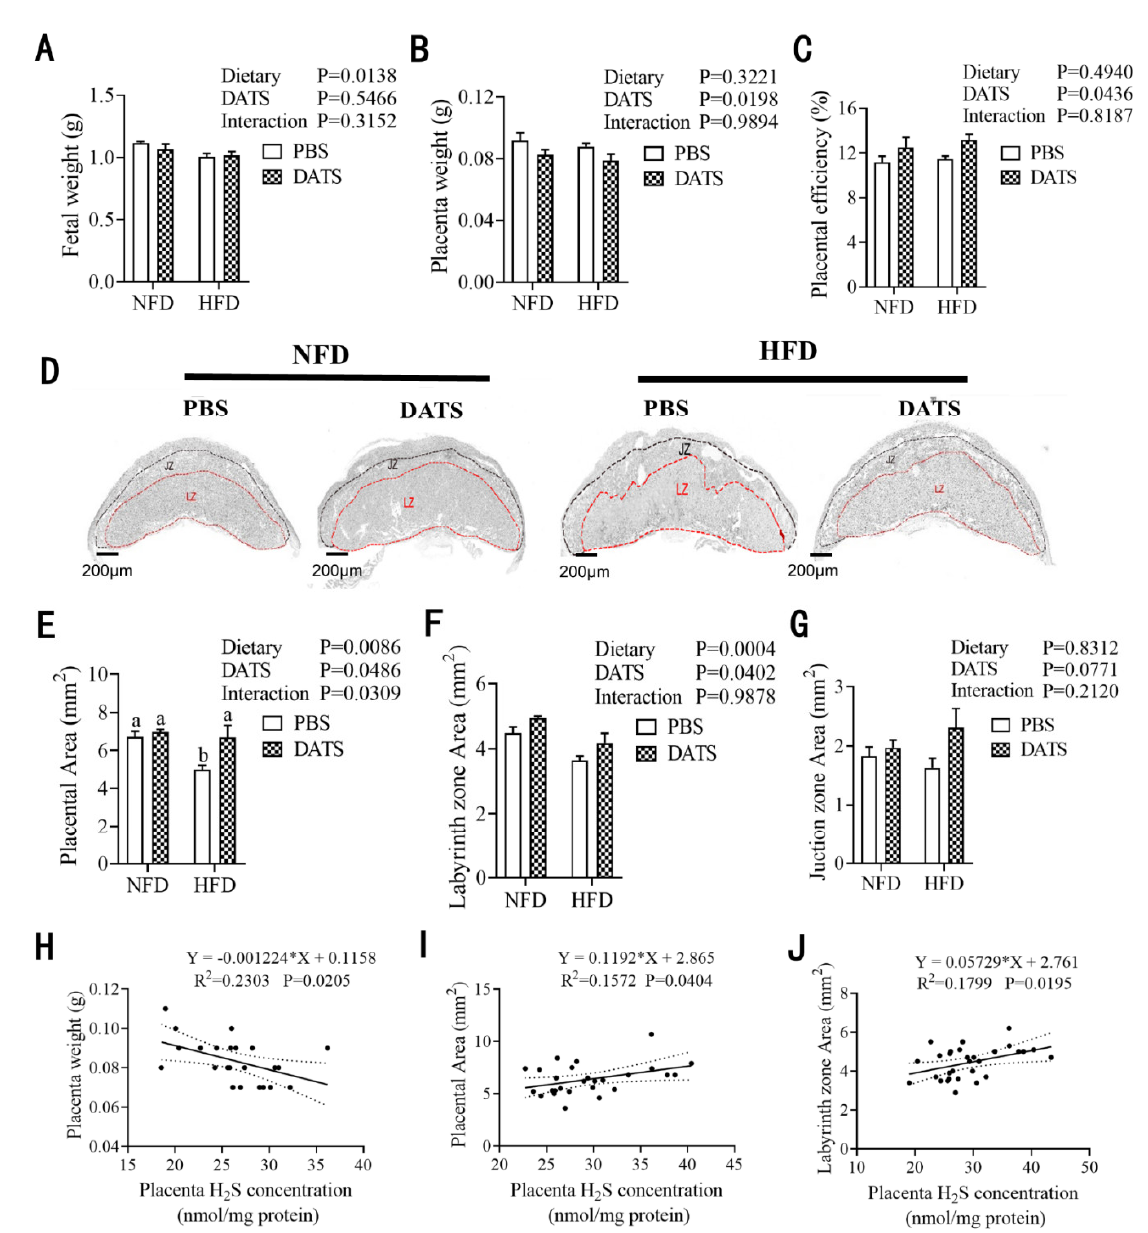
Figure 3. DATS treatment can improve placental development. ( A ) Fetal weight. ( B ) Placental weight. ( C ) Placental efficiency (fetal/placental weight ratio) ( n = 9–11 mice/group). ( D ) The morphology of placental hematoxylin and eosin (H&E) staining ( n = 8–11 placentas/group), scale bar 200 µ m, the red dotted line region represents the labyrinth zone (LZ) and the black dotted line region represents the junction zone (JZ). ( E ) The area of placenta. ( F ) The area of LZ. ( G ) The area of JZ (n = 8–11 mice/group). ( H – J ) Correlation analysis of H 2 S levels with placental weight, placental area and LZ area (n = 8–11 mice/group). Two-way ANOVA—the values represent the mean ± SEM, p < 0.05 was considered to indicate statistical significance and different letters indicate significant differences.